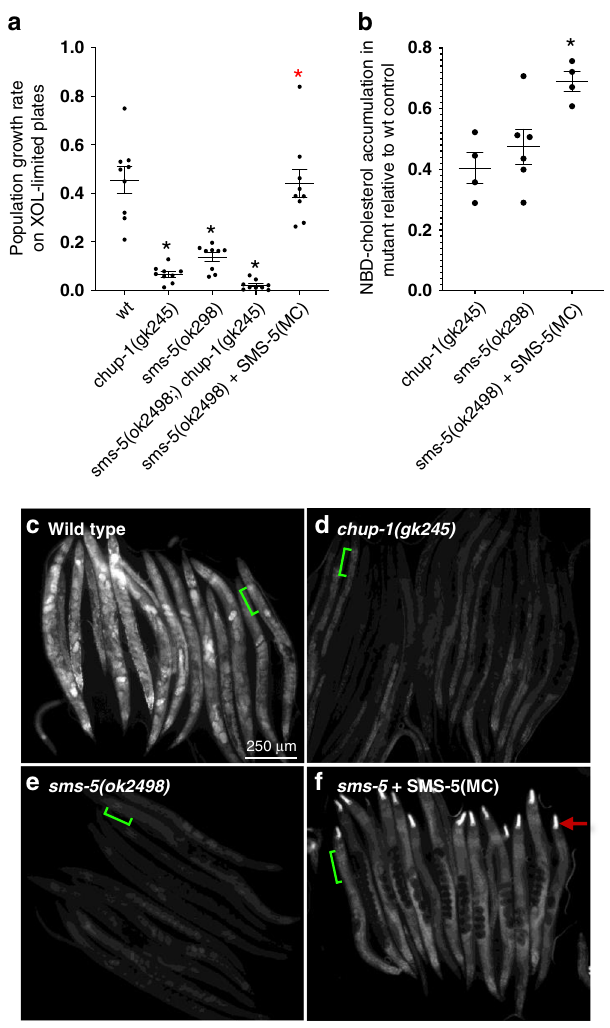
Fig. 9 SMS-5 is required for development in cholesterol-limited conditions. a The growth rate of animals of the indicated genotype grown on cholesterol (xol)-limited plates (containing 50ng/mL xol) is reported relative to the same strains grown on plates with standard concentrations of cholesterol (5000ng/mL xol) ( y axis). See “ Methods ” for additional details. Asterisks indicate signi fi cance ( p < 0.001) relative to the wild-type (wt) control; the red asterisks indicate signi fi cance ( p <0.05) relative to the sms-5(ok2498) deletion mutant. The double mutant has a more severe growth defect relative to either single mutant ( p = 0.06). n = 10 independent biological trials for the control (wt); n = 3 independent biological trials for all experimental genotypes. b Accumulation of NBD-cholesterol signal of the indicated mutants relative to wild-type controls. Black asterisks indicate signi fi cance ( p <0.01) relative to the wild-type control; red asterisk indicates signi fi cance ( p < 0.05) relative to the sms-5(ok2498) deletion mutant. n = 6 independent biological trials for wt and the sms-5 mutant; n = 3 independent biological trials for the other two strains. In both a and b , standard error of the mean is shown and signi fi cance is measured using Student ’ s T test. Source data are provided in the Source Data fi le. c – f Images of multiple animals after the indicated strains were incubated in NBD-cholesterol for 6 days. The scale is the same for all images. Green lines exemplify the area used in each animal to calculate signal in b . Red arrow indicates the expression of yellow fl uorescent protein that is restricted to the anterior pharynx that is used as a marker to follow the rescuing transgene trIs104 . In a , b , and f , SMS-5(MC) represents marginal-cell-speci fi c expression of SMS-5 from the trIs104 integrated transgenic array. Supplementary Fig. 9 shows that, in the absence of NBD-cholesterol, each strain auto- fl uoresces in the green fl uorescent protein channel to the same